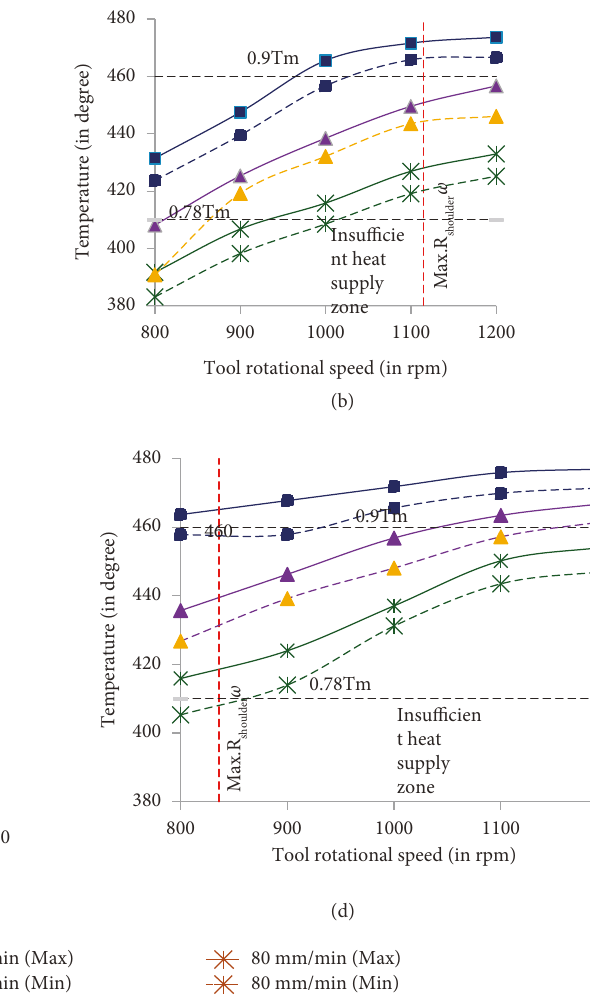
� 7.5mm; (b) R � 9mm; (c) shoulder shoulder